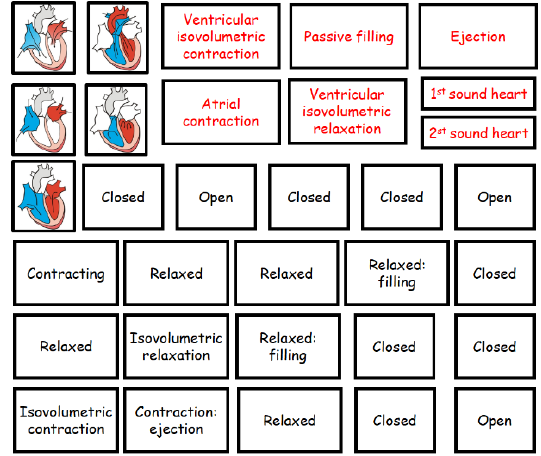
Figure 3. Chips for filling the table in stage 2 of printed cardiac cycle puzzle (adapted from Marcondes et al. 2015).